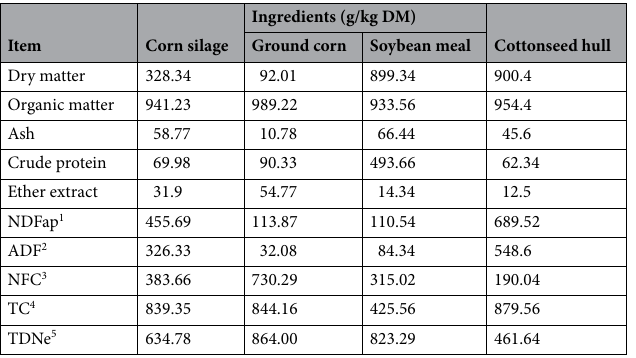
Table 4. Chemical composition of main ingredients in the experimental diets. 1 Neutral detergent fibre corrected for ash and protein. 2 Acid detergent fibre. 3 Non-fibrous carbohydrate. 4 Total carbohydrate. 5 Total digestive nutrient